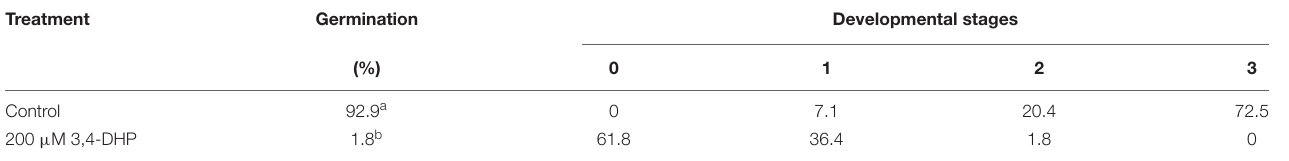
TABLE 3 | Effect of 3,4-DHP on symbiotic seed germination of D. officinale .